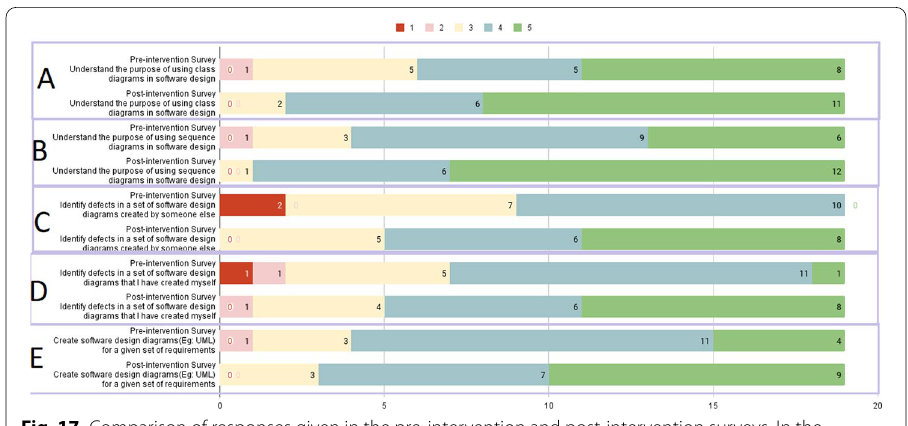
Fig. 17 Comparison of responses given in the pre-intervention and post-intervention surveys. In the surveys, 1 indicates “Not confident at all”, and 5 indicates “Absolutely